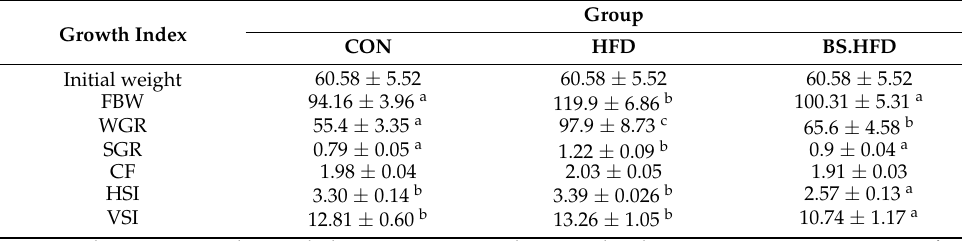
Table 2. Growth indices of C. idella .